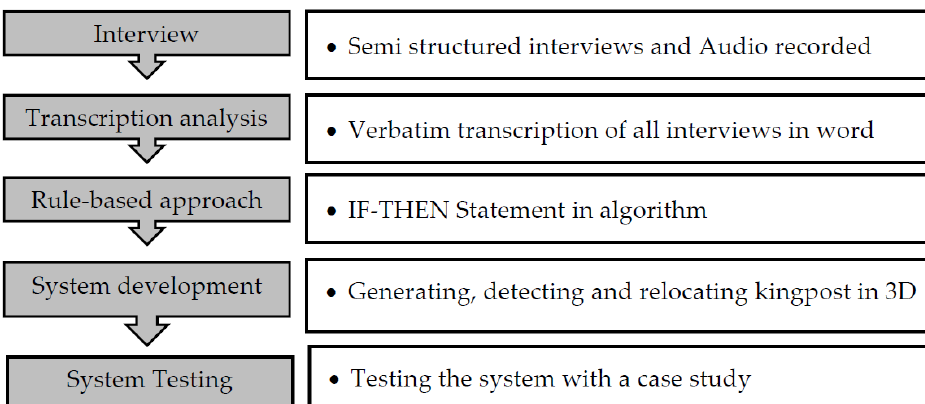
Figure 5. The research process methodology.